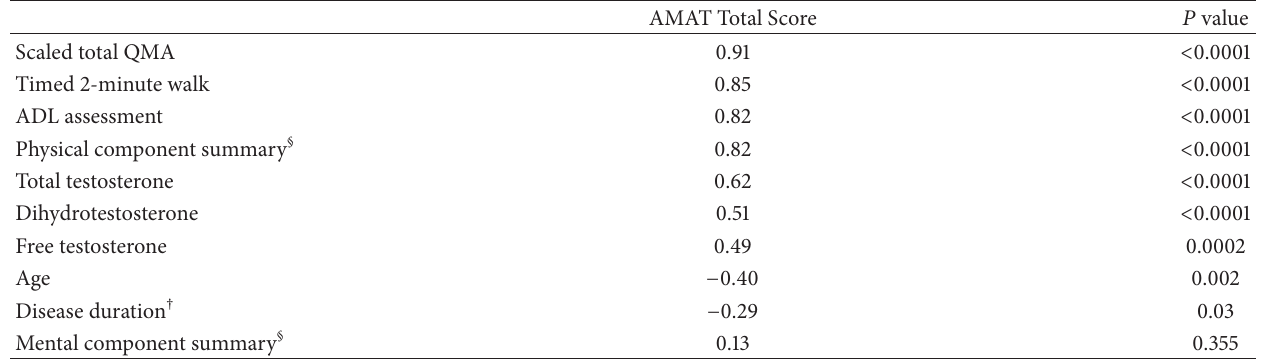
Table 3: Pearson’s correlation coefficients of the AMAT total score and SBMA outcome measures and phenotypic variables.